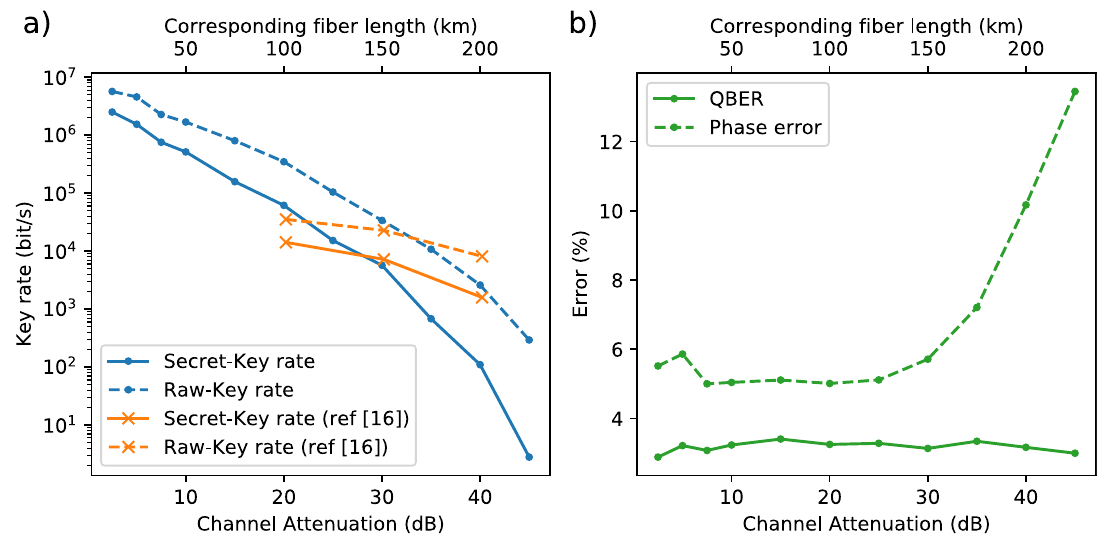
Fig. 5 Key rates and error rates. a Measured key rates and error rates over different levels of channel attenuation. With the demo setup we achieve 2.5 Mbit/s for an attenuation of 2.5 dB. Compared to the reference implementation 16 our setup bene fi ts from the shorter dead times of the detectors at low attenuation. b Quantum bit error rate (QBER) and phase-error rates vs. channel attenuation. Due to the low dark-count rates (DCR) of the SNSPDs no increase in QBER is observable for higher attenuations. Because only a small fraction of the incoming